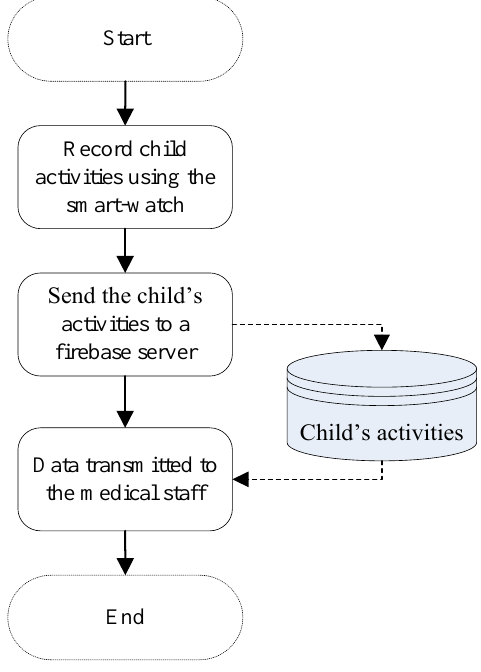
Figure 3. Flowchart for the smart-watch device function.